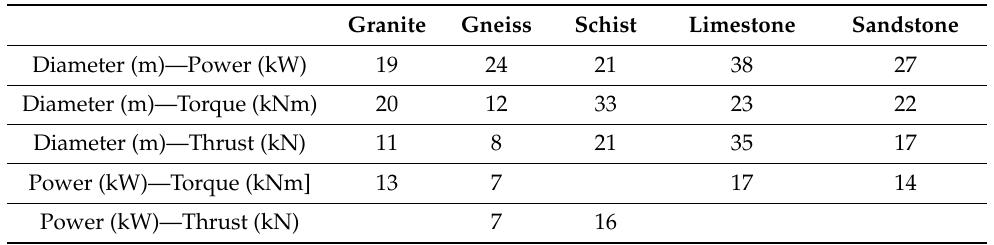
Table 2. Number of cases found in the literature to compare the main parameters of the TBM analyzed as a function of the rock mass